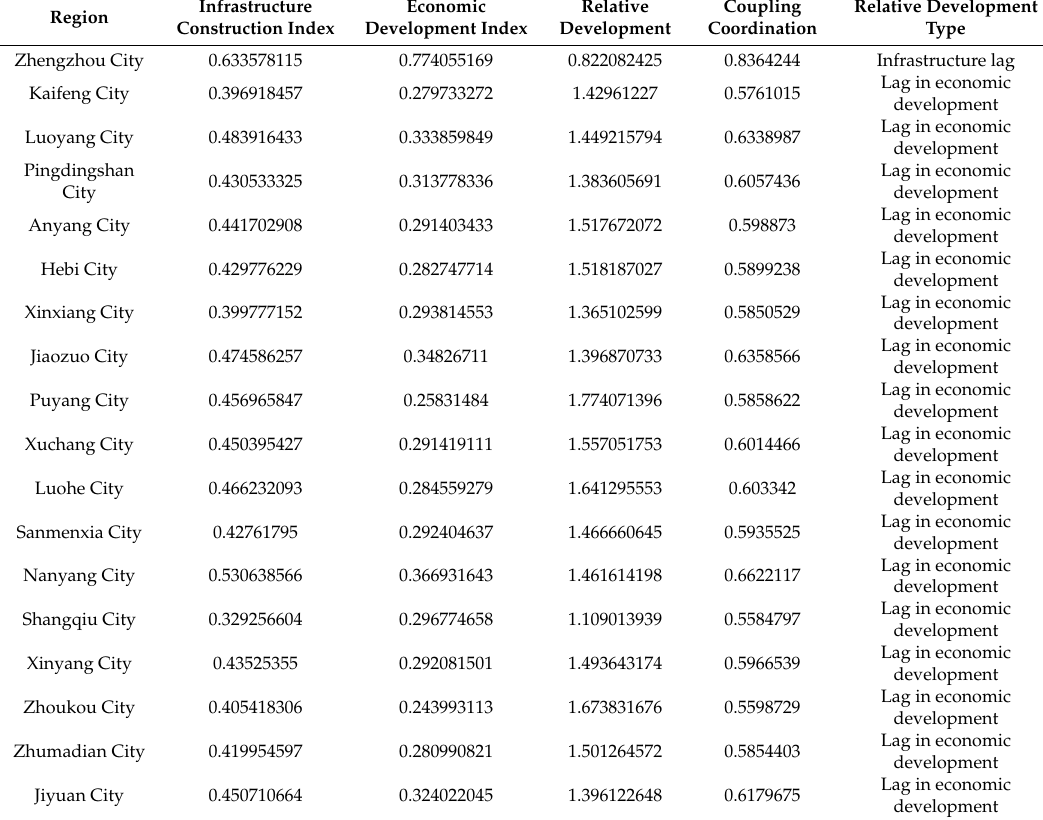
Table 4. Types of relative development of infrastructure construction and economic development level in